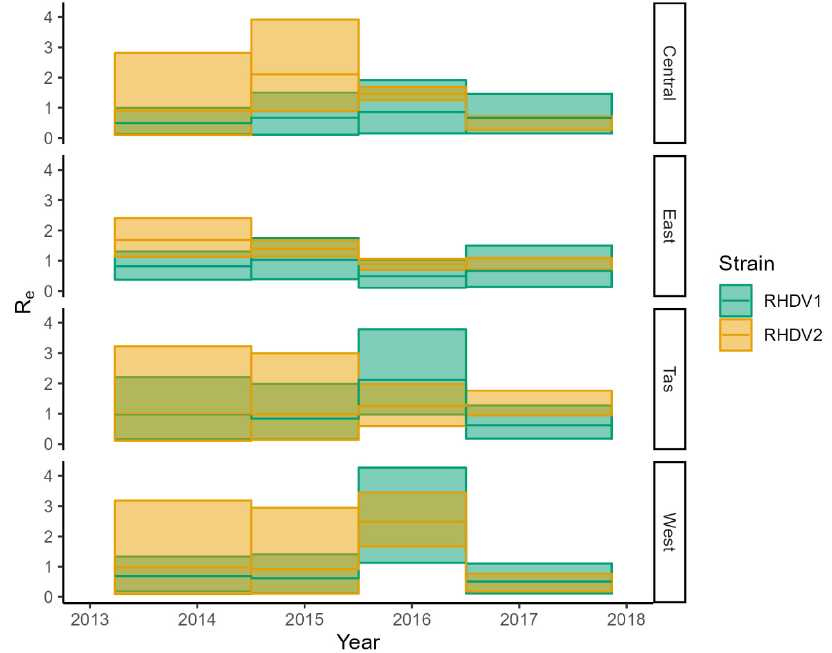
Figure 12. BDMM analysis of both strains (RHDV1 and RHDV2) with a joint multivariate lognormal distribution. Shaded areas show the 95% Highest Probability Density and solid lines are the posterior medians. Note how Re HPD mostly overlaps.